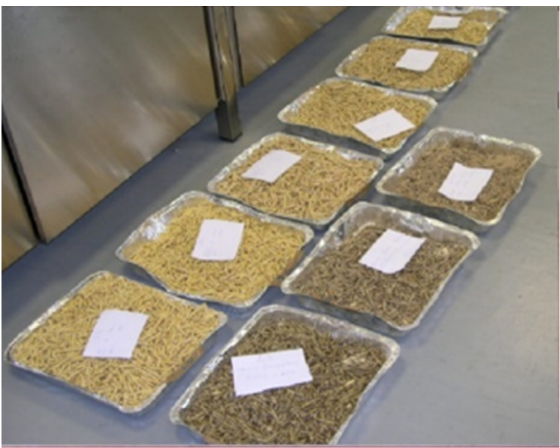
Figure 1. Agripellets produced.